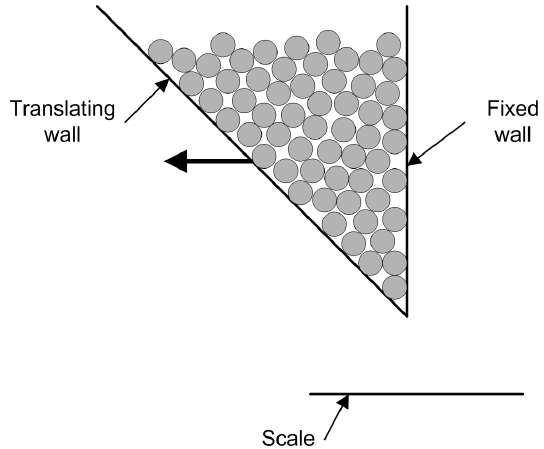
Figure 9 : Schematic of validation experiment. A linear actuator and translational stage moved the left angled side a fixed amount, opening a precise gap from which the particles flowed. The mass 7 flow rate was measured by the scale. Schematic not to scale.